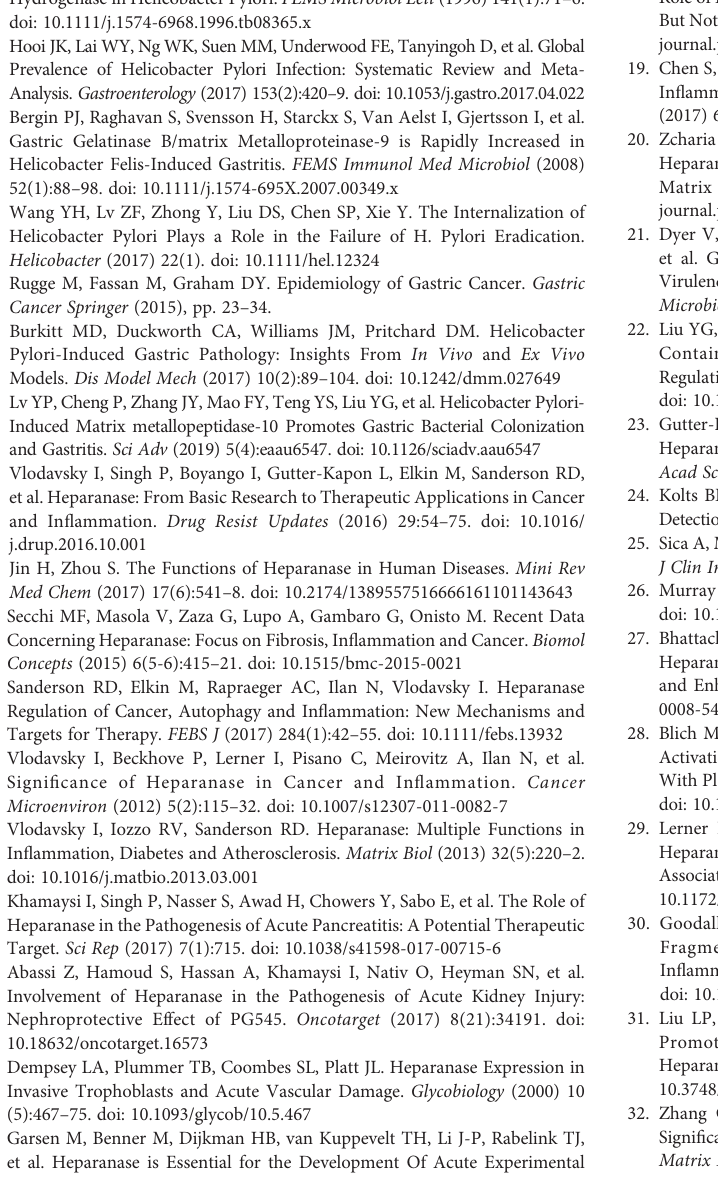
resuspendedwithsterilePBS.Aftercentrifugation,thesupernatantwasaddedonto bloodculture platecontainingantibioticsandcultured in5%O2,10%CO2and85% N2 incubator at 37°C for 48 hours. Left: Gray dots on the blood culture plate are colonies of H. pylori. Right: gram staining of H. pylori . Supplementary Figure 4 | FACS blanks for the detection of dendritic cells and macrophages using anti F4/80+, CD11b+, CD103+ and CD11c+ antibodies. Supplementary Figure 5 | ELISA quanti fi cation of cytokines. (A) ELISA quanti fi cation of the cytokines presented in Figure 5A . (B) ELISA quanti fi cation of thecytokinespresentedin Figure5C .KO-hp+:n=6;KO-hp-:n=6;WT-hp+:n=6; WT-hp-:n=3;KOcontrol:n=6;KO LPS+INF- g : n=6;WT control: n=6;WT-hp LPS+INF- g : n =6. *p<0.05; **p<0.01; *** p<=0.001; ns: no signi fi cant